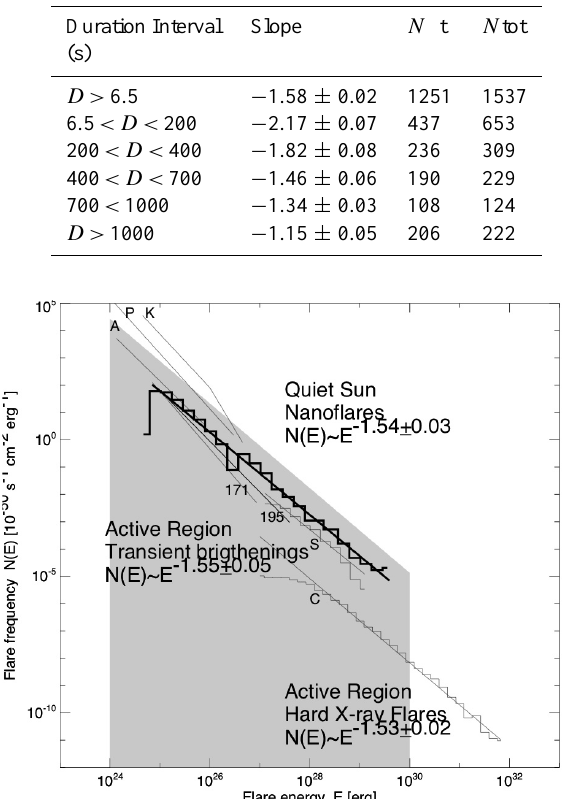
Table 1. Characteristics of the WATCH frequency distributions in peak count rate for sub-groups of events. N fit: number of events in the fit. N tot: total number of events in the distribution. Adapted from Crosby et al. (1998).